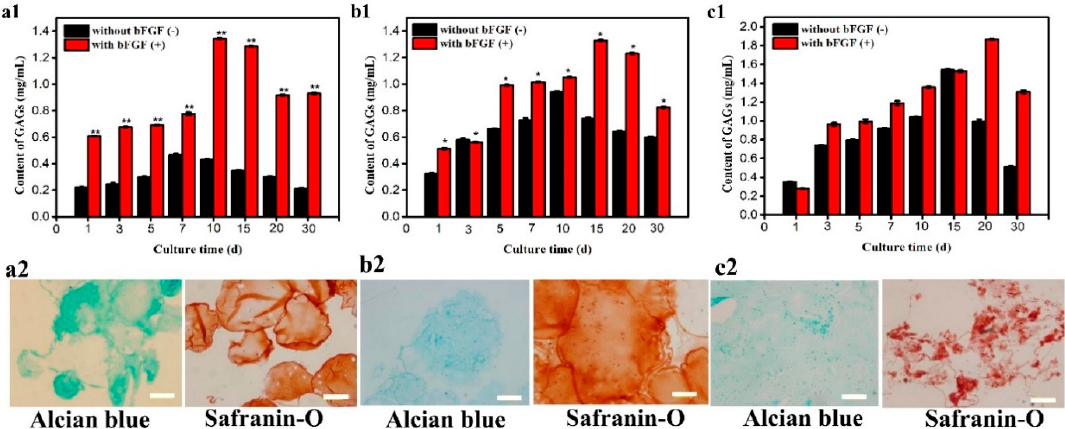
Figure 5. Glycosaminoglycan (GAG) content detection by 1,9-dimethylmethylene blue (DMB) under different culture conditions: ( a 1 ) Static, ( b 1 ) shaking, and ( c 1 ) RCCS (** p < 0.01, * p < 0.05); alcian blue staining and safranin-O staining of artificial C5.18 cells with bFGF under different culture conditions: ( a 2 ) Static, ( b 2 ) shaking, and ( c 2 ) RCCS. Bar is 100 µ